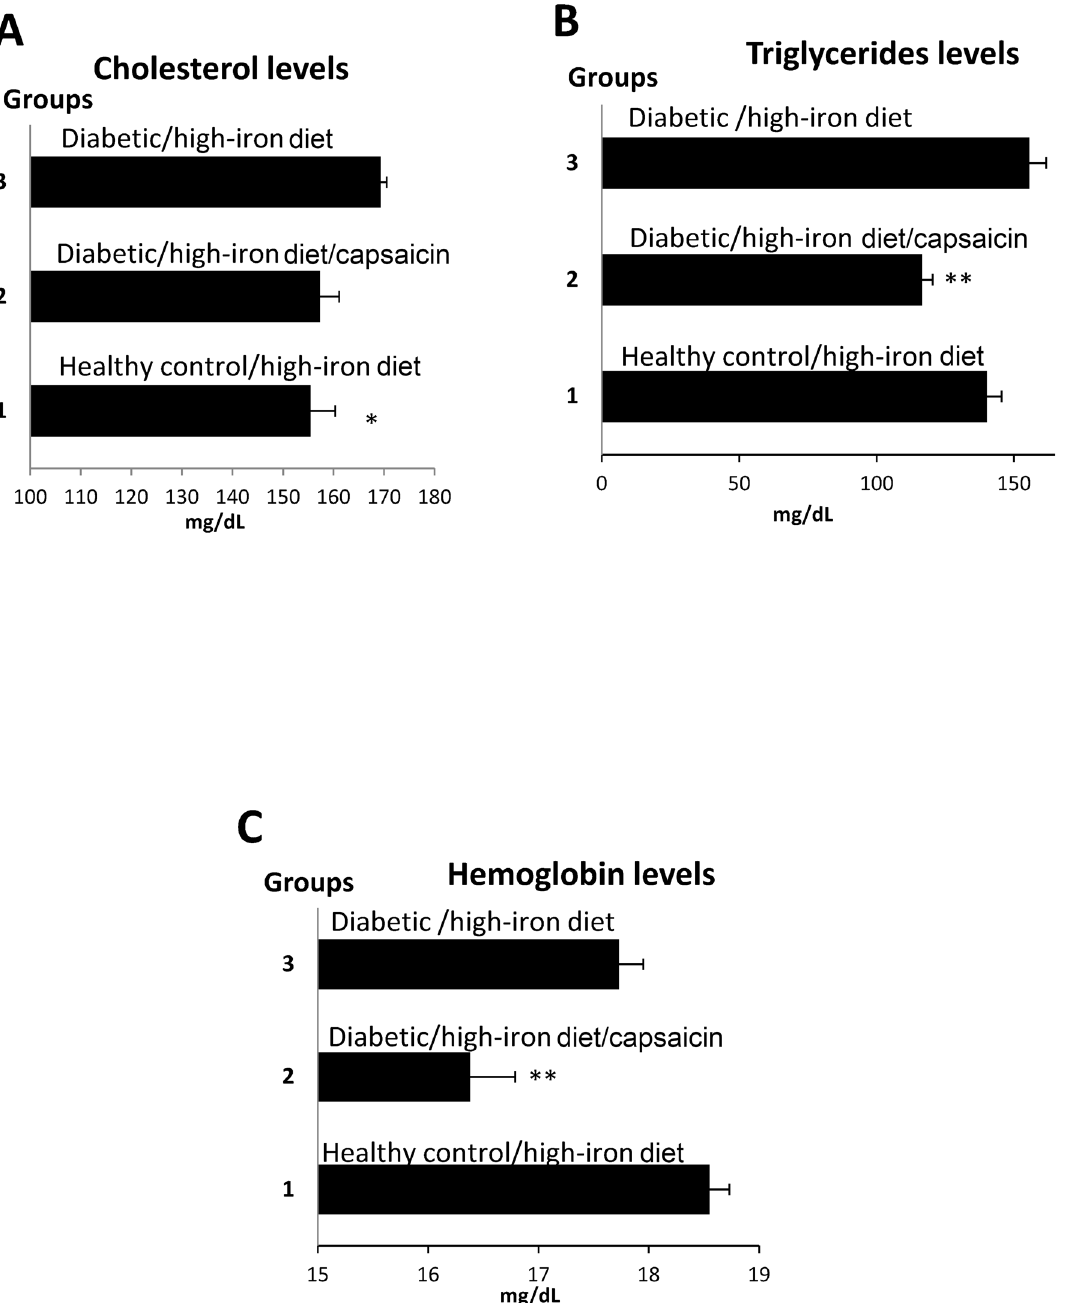
Fig 4. Effects of a high-iron diet, with or without capsaicin, on rats with STZ-induced diabetes. Diabetic and healthy rats were analyzed after 4 weeks on a high-iron diet (n = 10), or a high-iron diet plus capsaicin (3mg/kg body weight/day) (n = 10) (A) Cholesterol levels. (B)Triglyceride levels. (C) Hemoglobin levels. Bars represent the mean and standard error; p- values assessed with ANOVA. For (A) p < 0.05 when comparing group 1 vs . groups 2, and 3; for (B) p < 0.001 when comparing group 2 vs . group 1, and 3 (C) p < 0.001 when comparing group 2 vs . groups 1, and 3. ** p < 0.001, * p < 0.05.